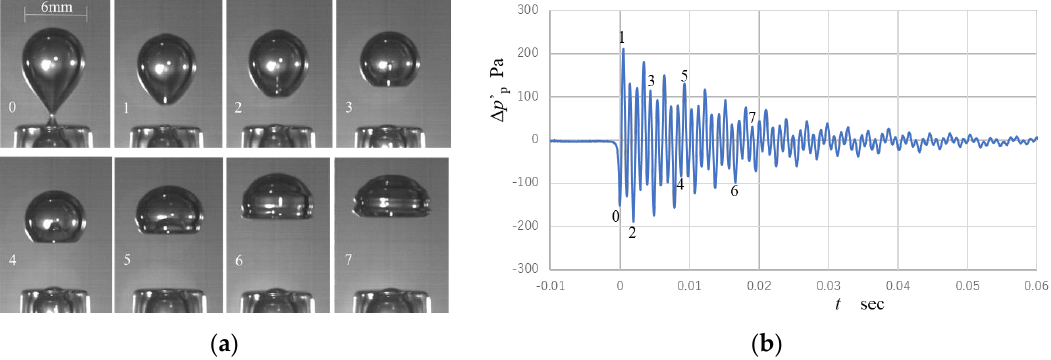
Figure 2. Typical deformation of bubble detachment and the corresponding pressure waveform in the experiment. The nozzle inner diameter, φ = 6 mm and air flow rate, Q = 0.186 mL/s. ( a ) Flow visualization of bubble detachment. ( b ) Experimental pressure signal by hydrophone.